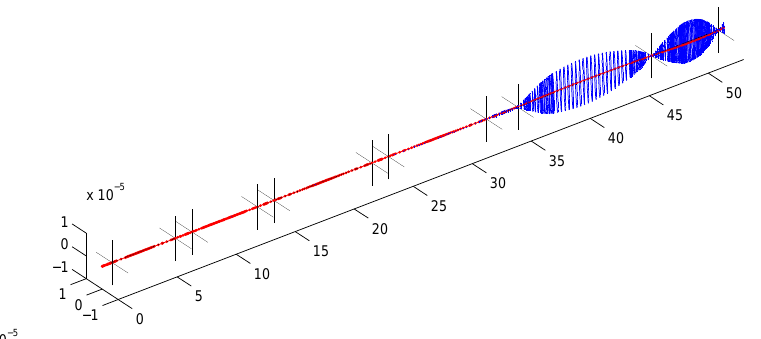
Figure 10. Visualization of the rotor mode shape with dominant deformation of the generator and the exciter (calculated using model